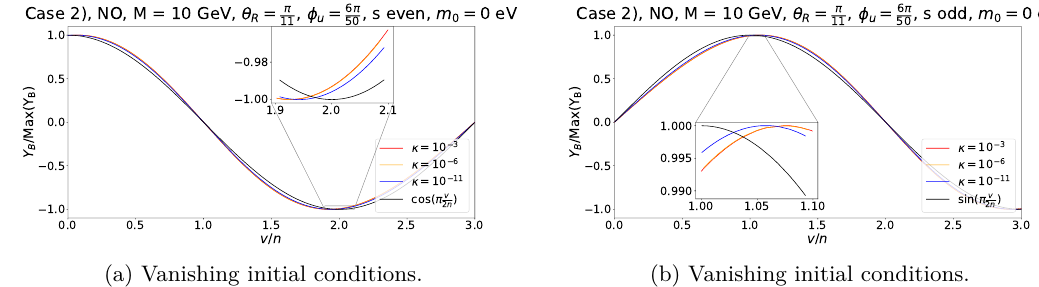
, treated as continuous parameter, for a Majorana mass n . This choice of u corresponds to t even and s 50 (cid:1) (for (cid:0) πv (cid:1) s even) and sin 2 n 2 n